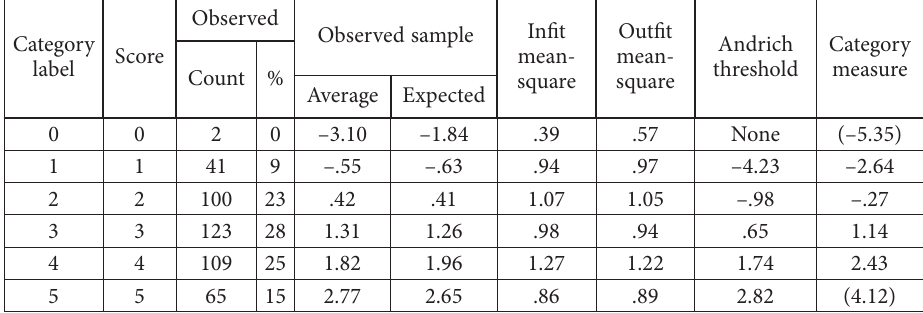
Table 5. Rating output table (partial credit) scale (source: created by authors)